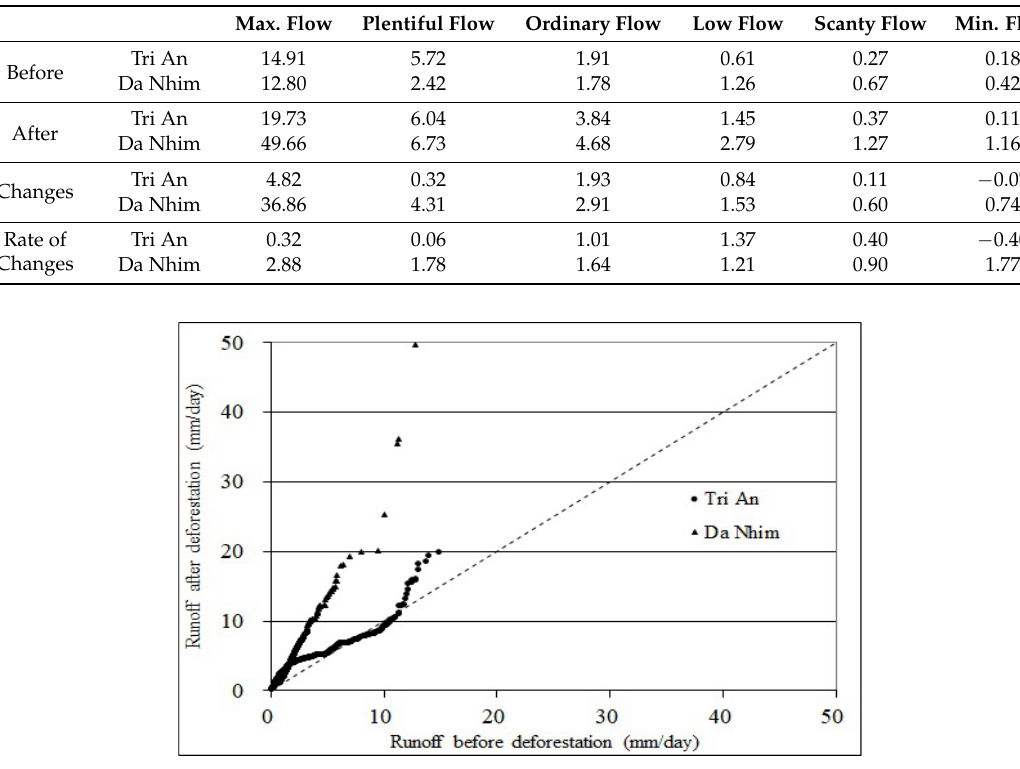
Table 8. Index of FDCs before and after deforestation (mm/day).